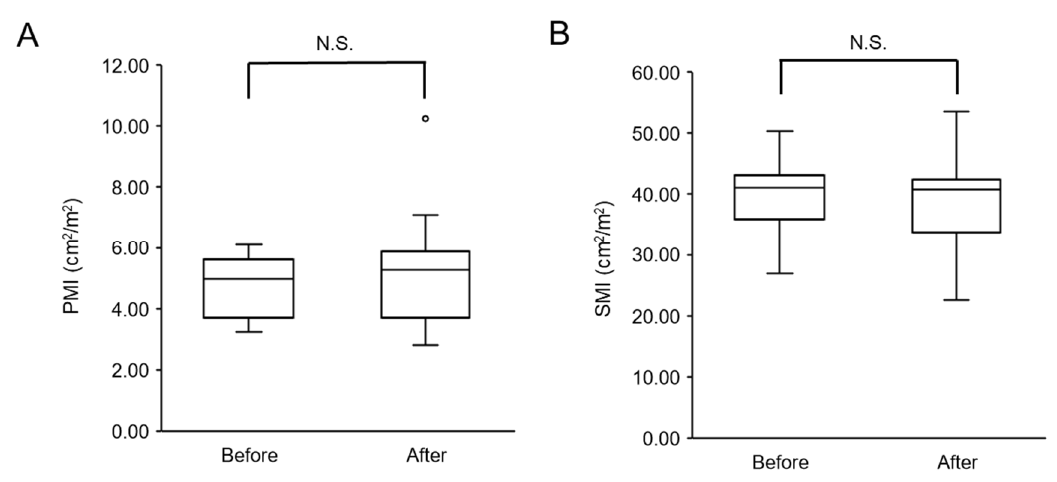
Figure 1. Changes in skeletal muscle mass after physical therapy: ( A ) psoas muscle index (PMI) and ( B ) skeletal muscle index (SMI). N.S.—not significant.